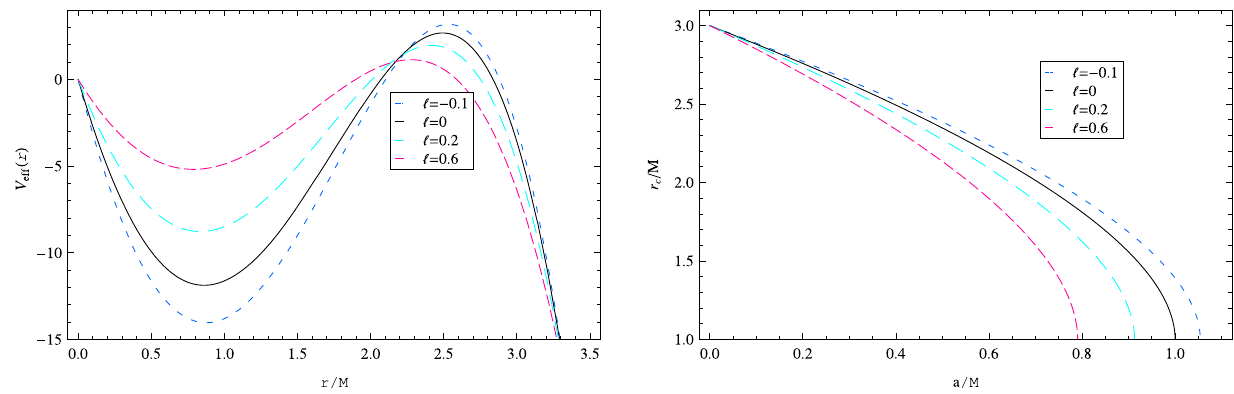
Fig. 1 The left panel describes the effective potential. The right one shows the radius r c of the equatorial circular